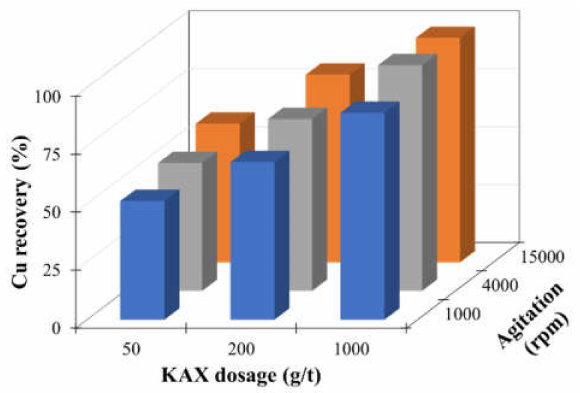
Figure 8. E ff ects of KAX dosage and agitation speed on Cu recovery (Kerosene dosage 15 L kerosene / t sample, flotation time 10